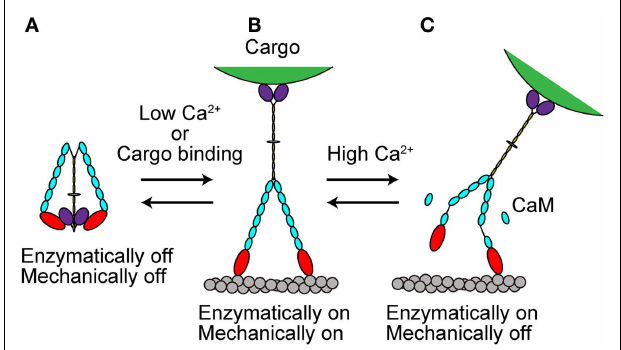
FIGURE 4 | Regulation of myosinVa. (A) When cargo is not present, myosinVa adopts a folded, inhibited conformation in the absence of Ca 2 + . (B) At low Ca 2 + concentrations or with cargo binding in the absence of Ca 2 + , myosinVa becomes unfolded and active. (C) At high Ca 2 + concentrations, the processive movement of myosinVa is inhibited via dissociation of CaM molecules.